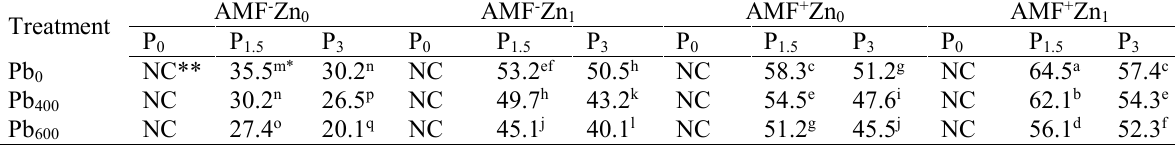
Table 6. Effects of Zn oxide nanoparticles, Pb, and AMF on petroleum hydrocarbon degradation (%)